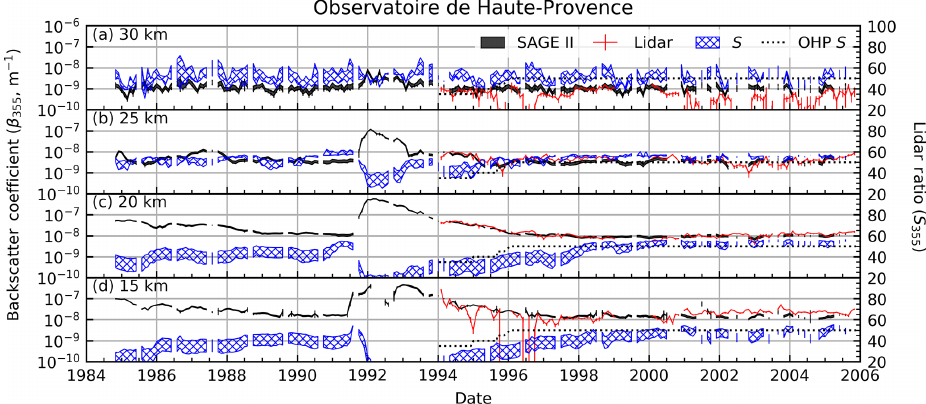
Figure 7. Same as Fig. 6, but for OHP. Dots mark the lidar ratio as estimated within the OHP record.